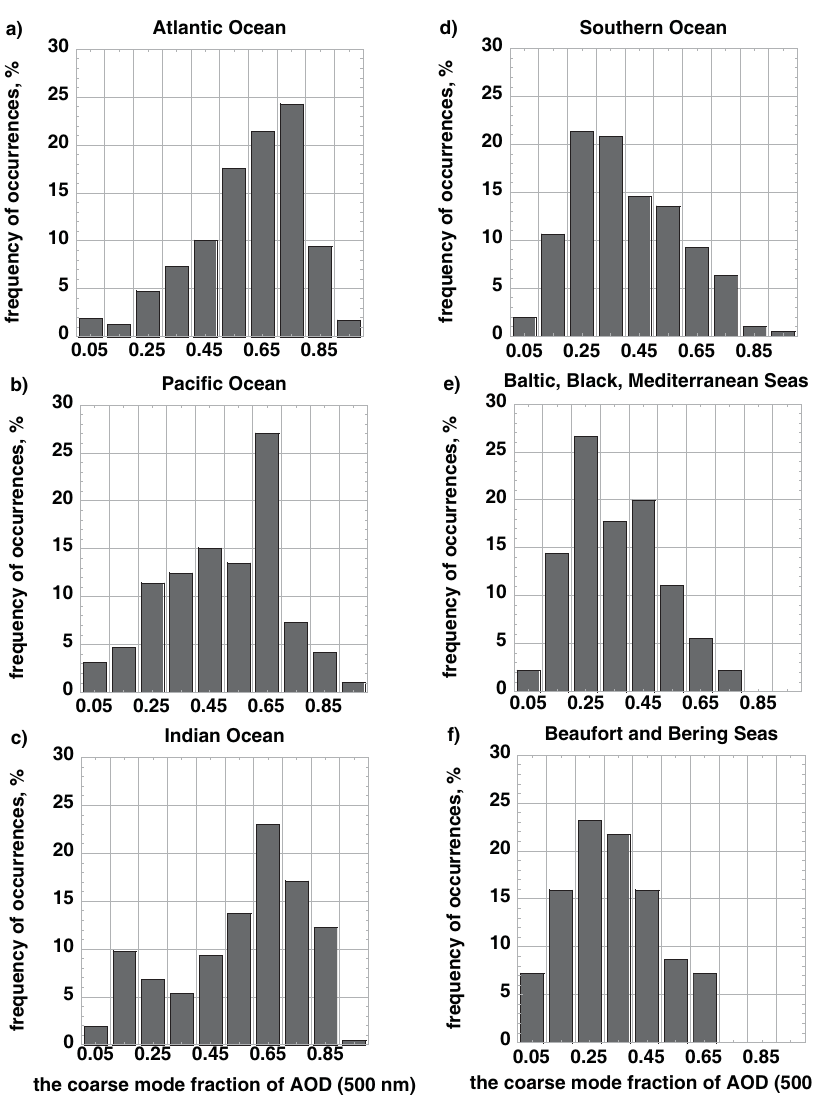
Fig. 6. Frequency of occurrences of the daily averaged coarse mode fraction for (a) Atlantic Ocean, (b) Pacific Ocean, (c) Indian Ocean, (d) Southern Ocean, (e) Baltic, Black, and Mediterranean Seas, (f) Bering and Beaufort Seas.